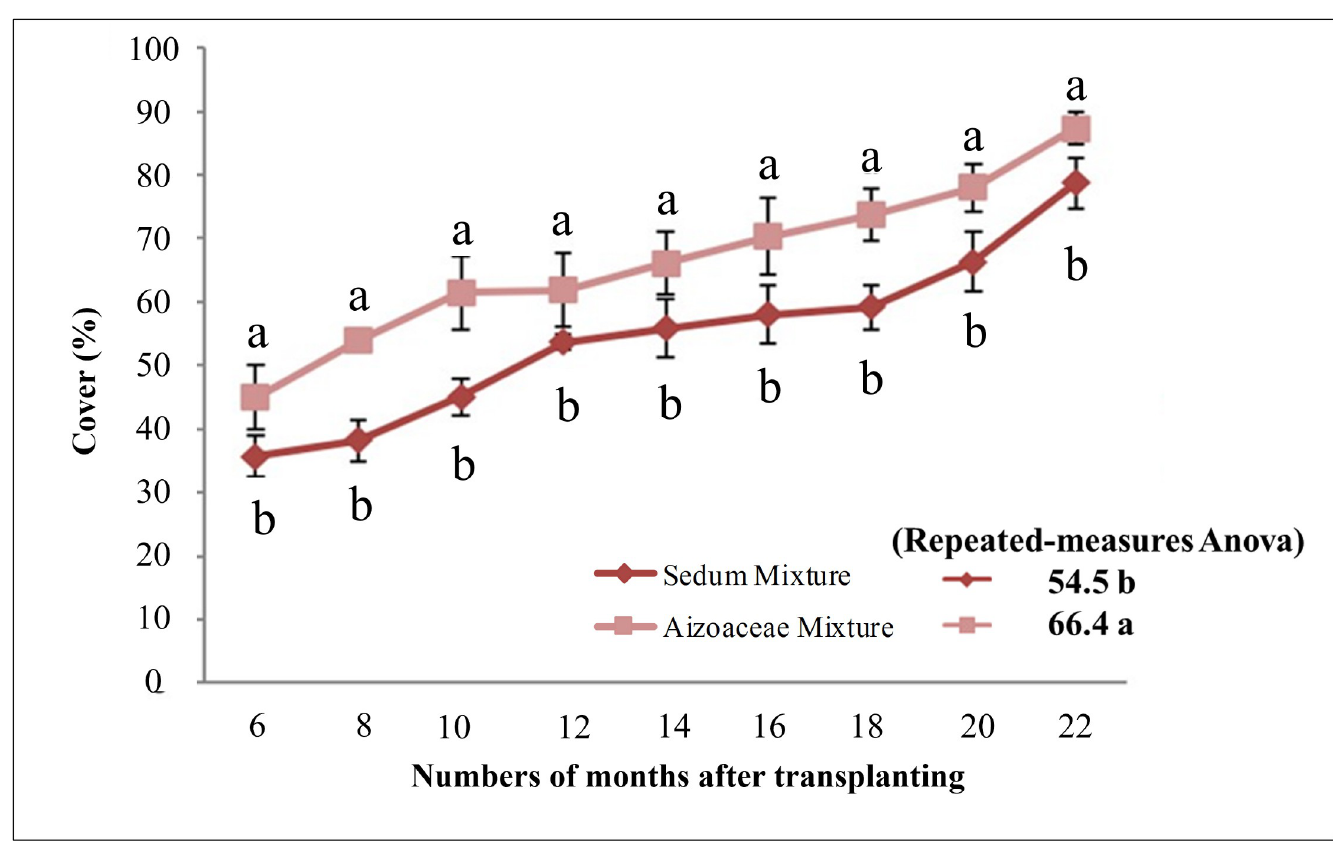
Fig 4. Cover percentage from 6 months to 22 months after transplanting. Values are means ± SE. For each data, histograms with different letters are significantly different at p � 0.05.